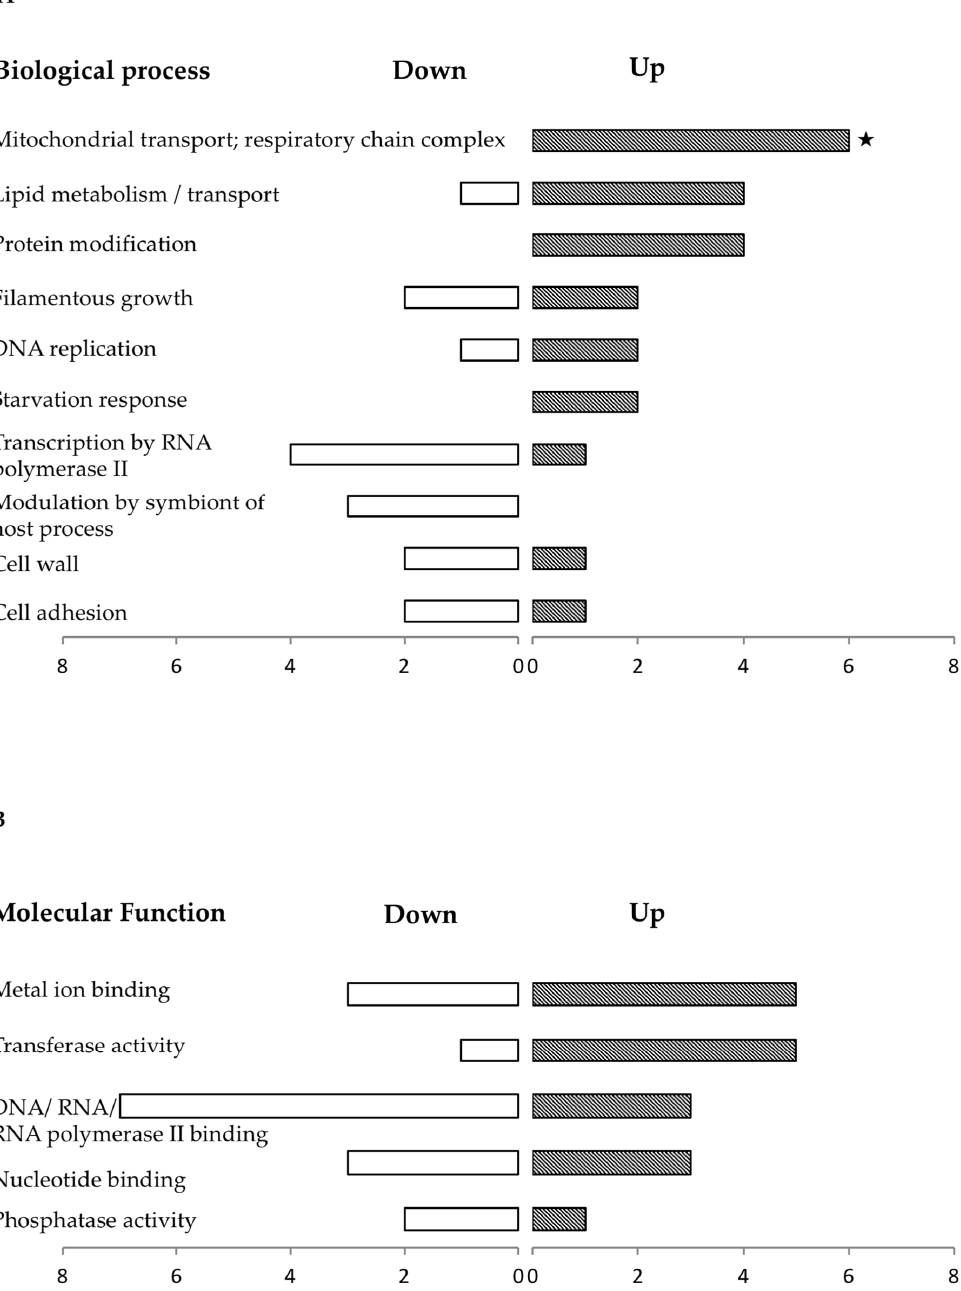
Figure 6. Functional distribution of the proteins found differentially expressed in the dpp3delta mutant compared with the REC strain. Proteins were classified according to the biological processes ( A ) or molecular functions ( B ) with which they are associated based on their predicted functions using gene ontology (GO) annotations of C. lusitaniae (ATCC42720) and C. albicans (SC5314) in the Uniprot database. The number of proteins down-regulated or up-regulated can be read on the horizontal axis. Since proteins can be linked to more than one annotation group, the sum of annotated genes is larger than the number of total up- and down-regulated genes in the set analyzed. The categories found statistically enriched by the DAVID tool (https://david.ncifcrf.gov, accessed on 28 October 2022) are marked with an asterisk ( p -value < 0.05). Because the analysis was performed using C. lusitaniae reference genome ATCC42720, enrichment of some biological processes annotated from C. albicans SC5314 could not be